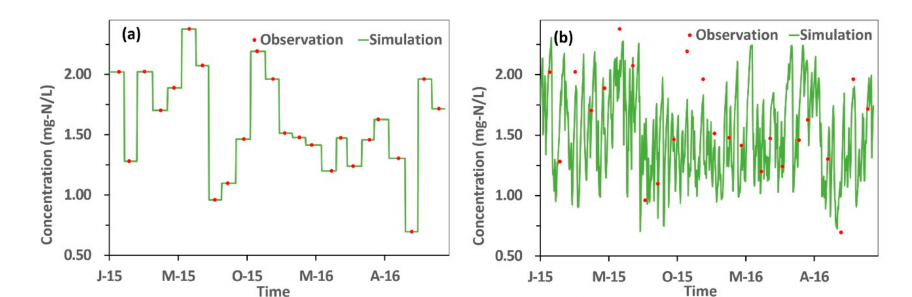
Figure 2. The model-fitted NO 3 - concentration of site no.1 for an unmeasured time sequence based on ( a ) a rectangular interpolation and ( b ) a simple linear regression model using functions in the loadflex package. The red points and green line stand for observations and concentration predictions,